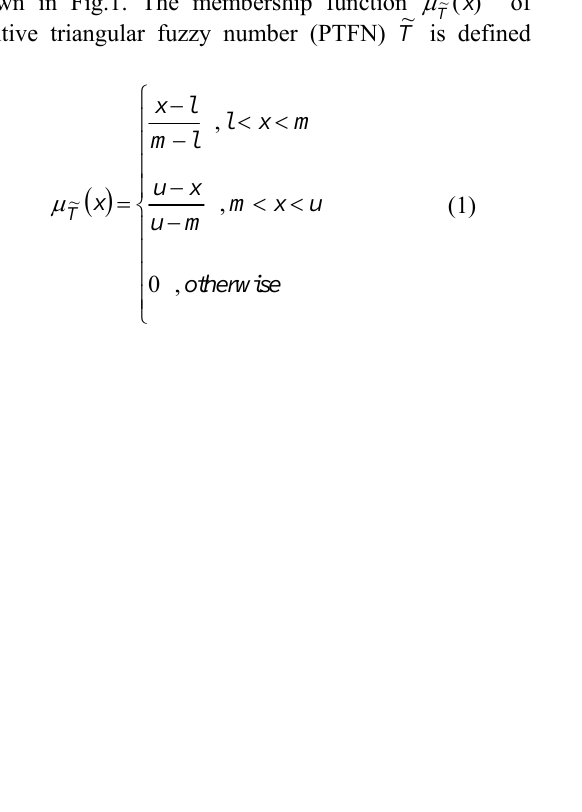
Fig. 1. Triangular fuzzy number T